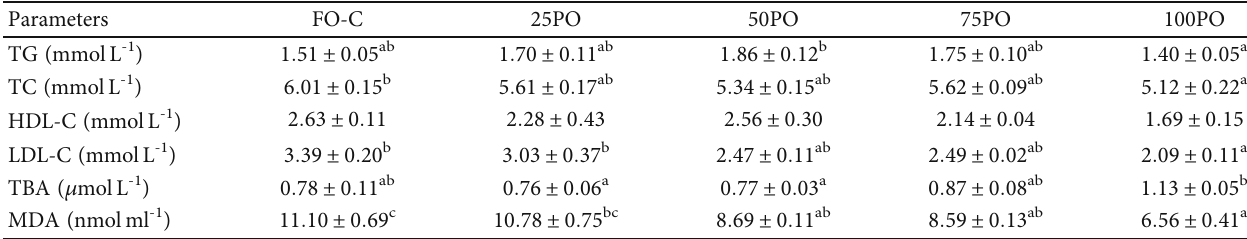
Table 6: Serum biochemical indices of experimental tiger pu ff er ( mean ± standard error